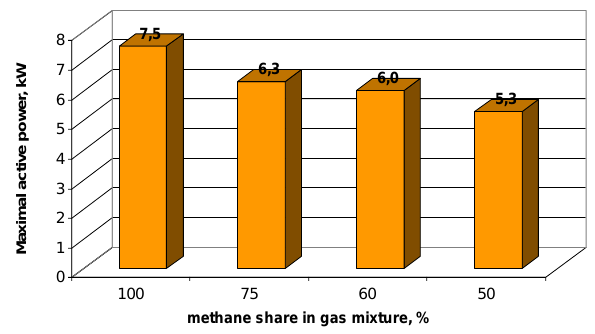
Fig. 7. Maximum value of active electrical